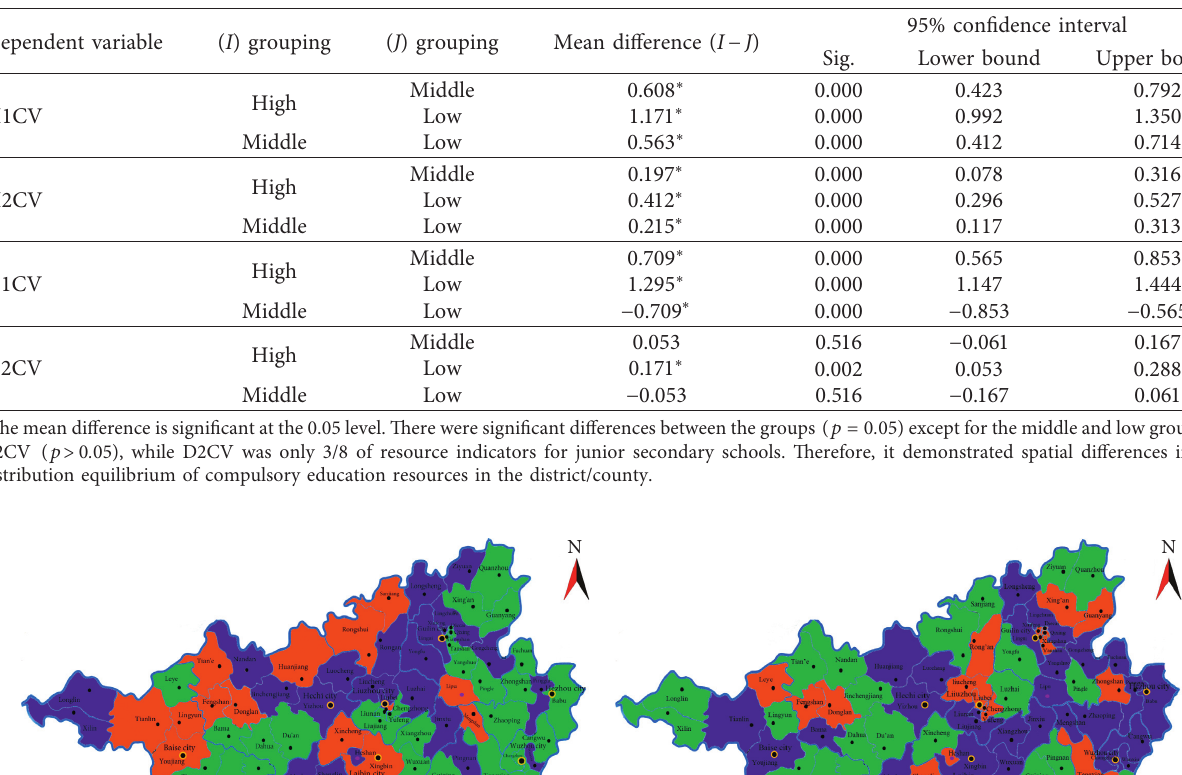
Table 5: Multiple comparisons with the Tukey HSD method.